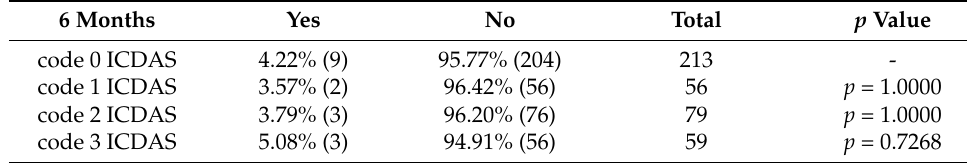
Table 7. Presence of carious lesions at 12 months.